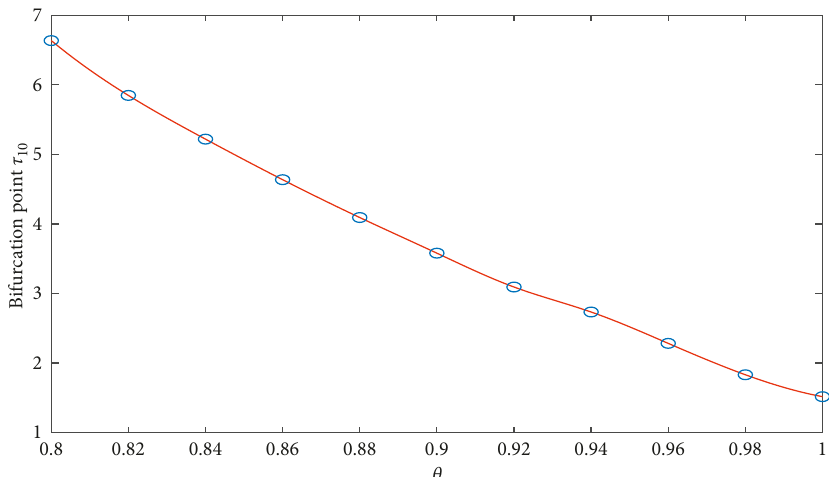
Figure 8: Case 4: effect of θ on bifurcation point τ